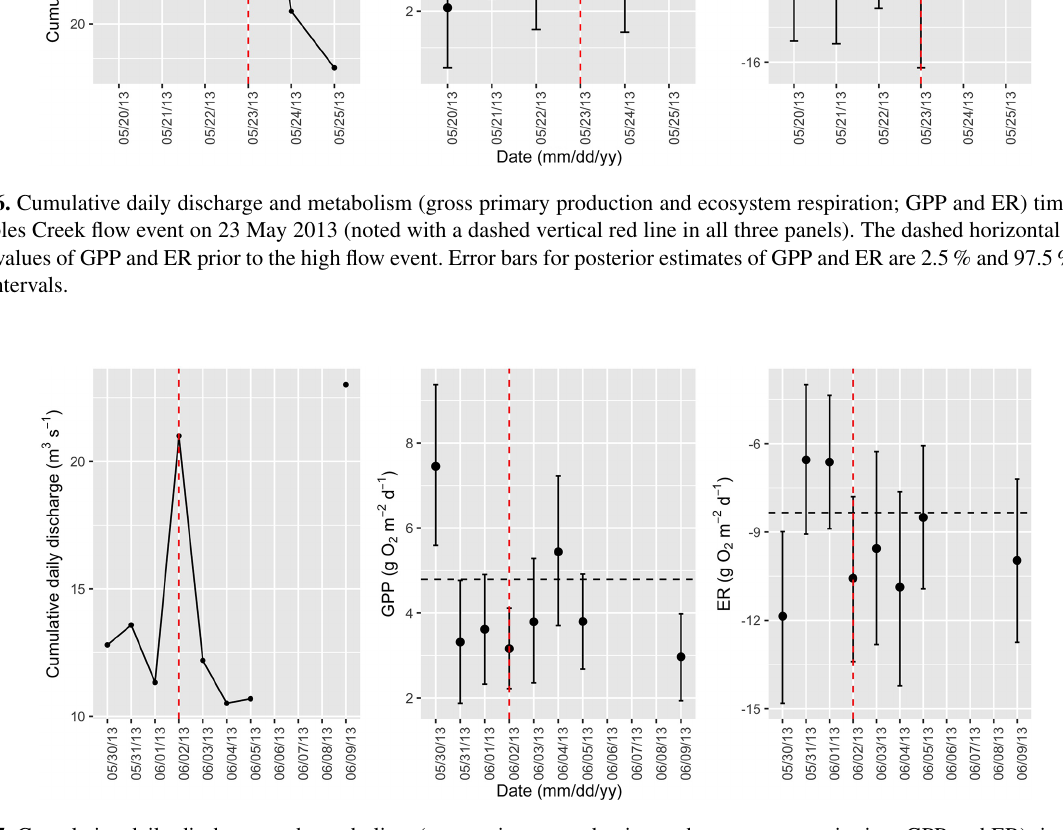
Figure A7. Cumulative daily discharge and metabolism (gross primary production and ecosystem respiration; GPP and ER) time series for the Stroubles Creek flow event on 2 June 2013 (noted with a dashed vertical red line in all three panels). The dashed horizontal black lines are mean values of GPP and ER prior to the high flow event. Error bars for posterior estimates of GPP and ER are 2.5% and 97.5% Bayesian credible